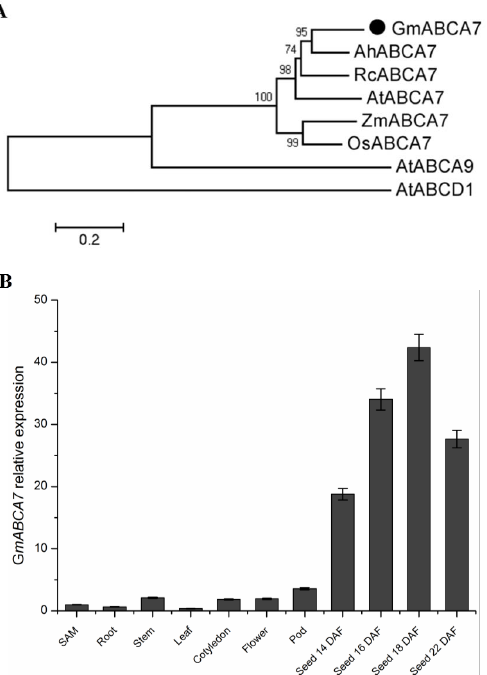
Figure 1. Phylogenetic analysis of GmABCA7 and its expression patterns in different tissues from Glycine max . ( A ) Phylogenetic tree analysis of GmABCA7 protein and other homologs from Glycine max (GmABCA7, MH910628); Arabidopsis thaliana (AtABCA7, NP_190362; AtABCA9, NP_200981; AtABCD1, NP_001328232); Arachis hypogaea (AhABCA7, XP_025701693); Ricinus communis (RcABCA7, XP_015579513); Oryza sativa (OsABCA7, XP_015651056) and Zea mays (ZmABCA7, XP_008652604). ( B ) Expression analysis of GmABCA7 in different soybean tissues by qRT-PCR. Roots, stems, SAMs and leaves from two-week seedlings, opening flowers and pods from adult plants, and seeds at 14, 16, 18 and 22 DAF were collected for